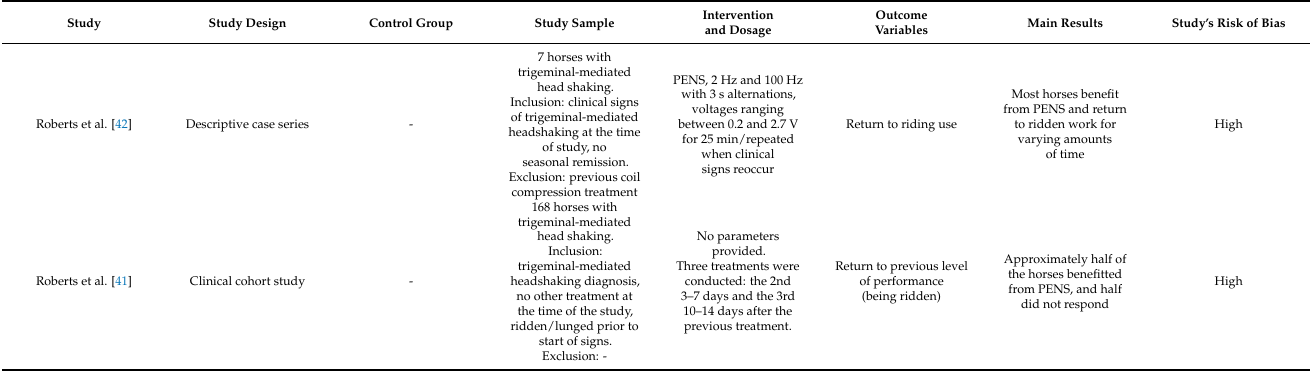
Table 7. Review of articles regarding percutaneous electrical